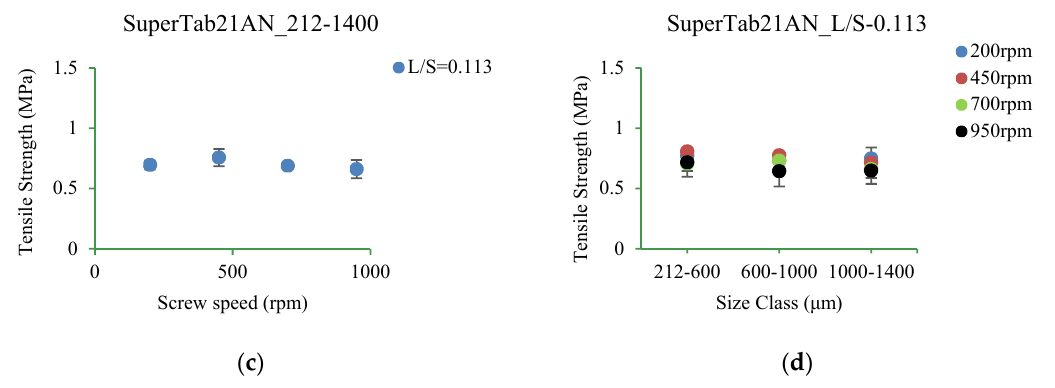
Figure 17. Tensile strength of tablet of granules at different size classes of SuperTab21AN. ( a ) 212–